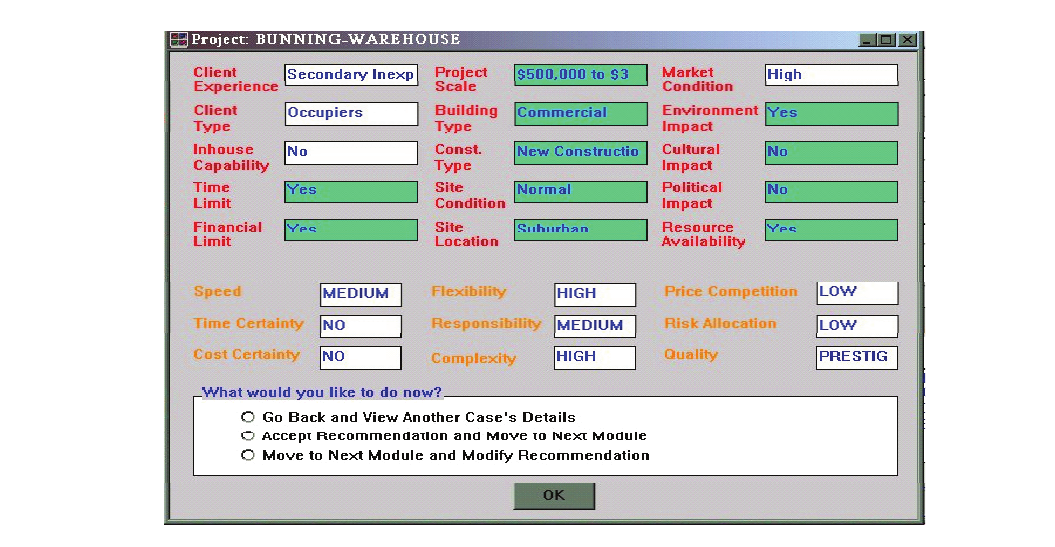
Figure 7: Solution adopted in the previous case during PSPs formulation